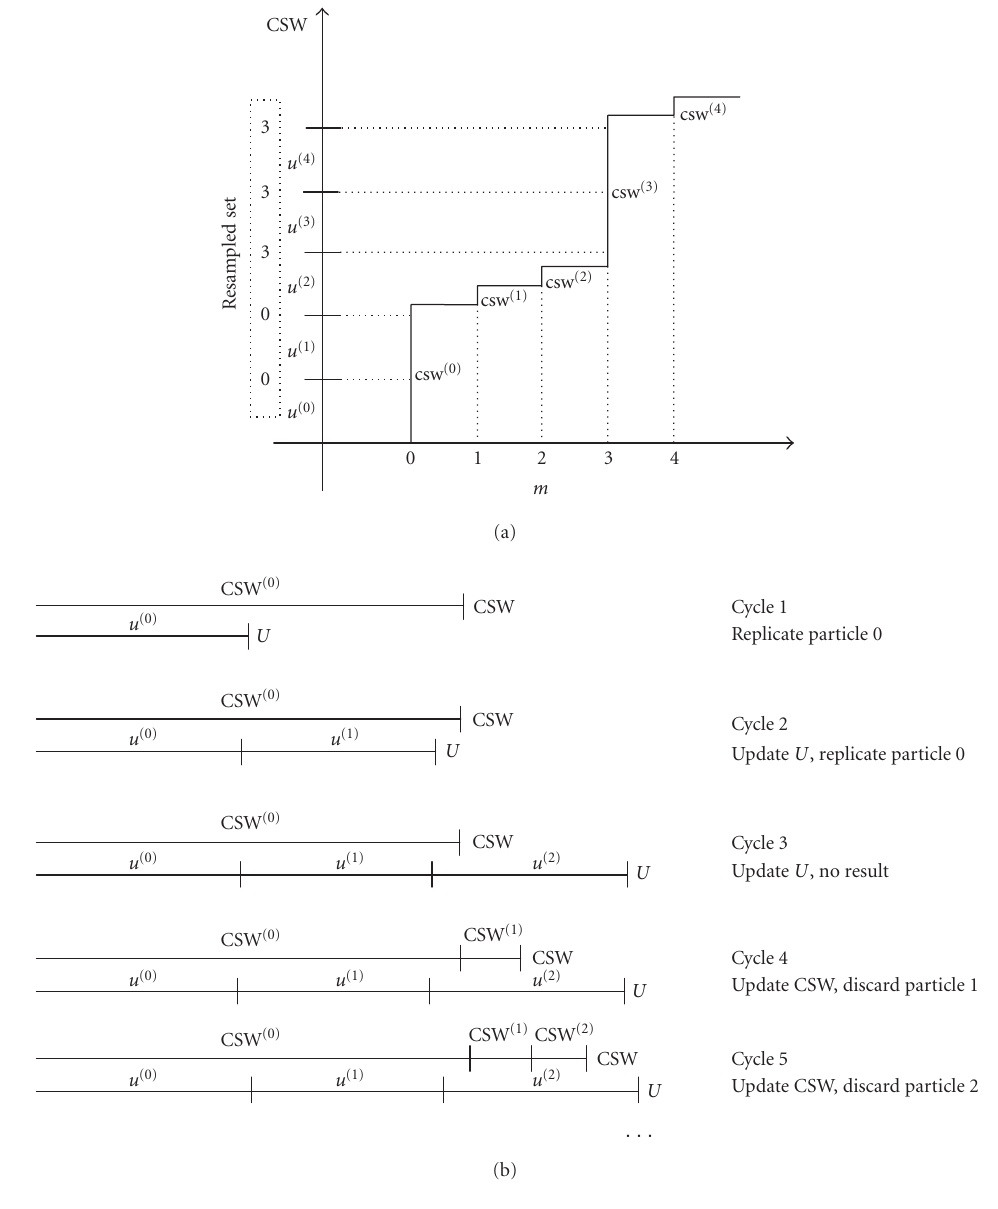
Figure 2: The concept of systematic resampling. (a) Resampling using cdfs. (b) Resampling done